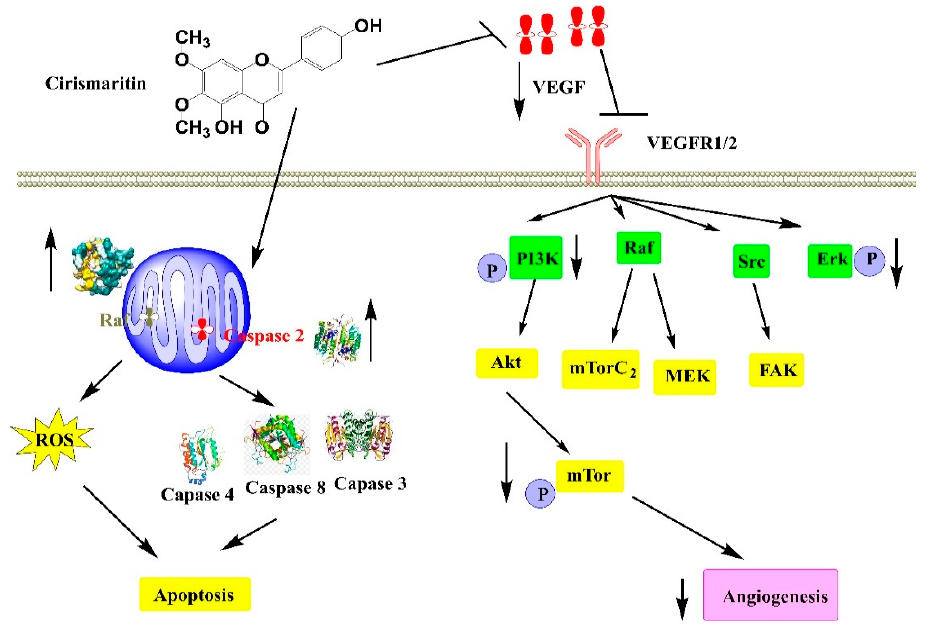
Figure 5. Anticancer mechanisms of cirsimaritin.